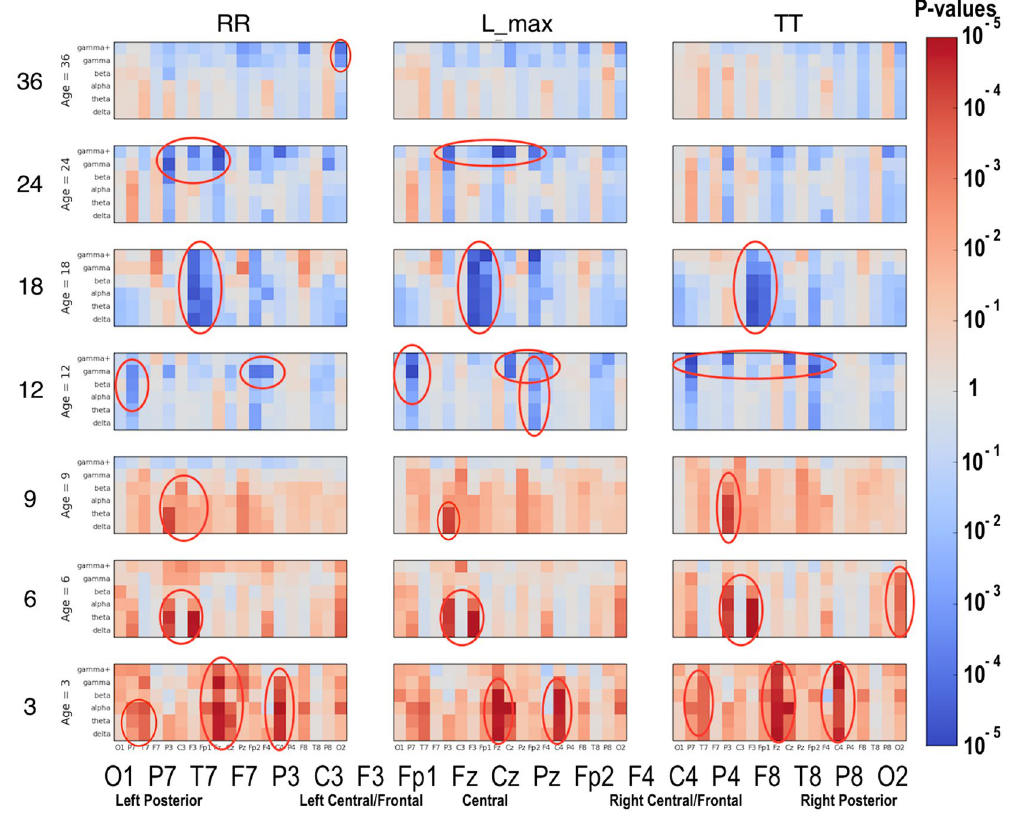
Figure 6. Similar to Fig. 5: differences between ASD and LRC − group values for RR, L_max, and TT are shown using color for every nonlinear